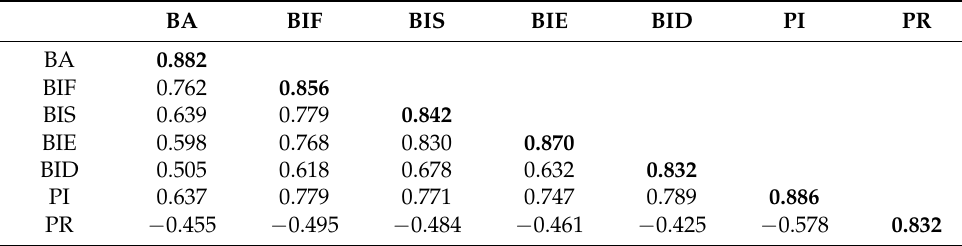
Table 8. Discriminant Validity for the Measurement Model.